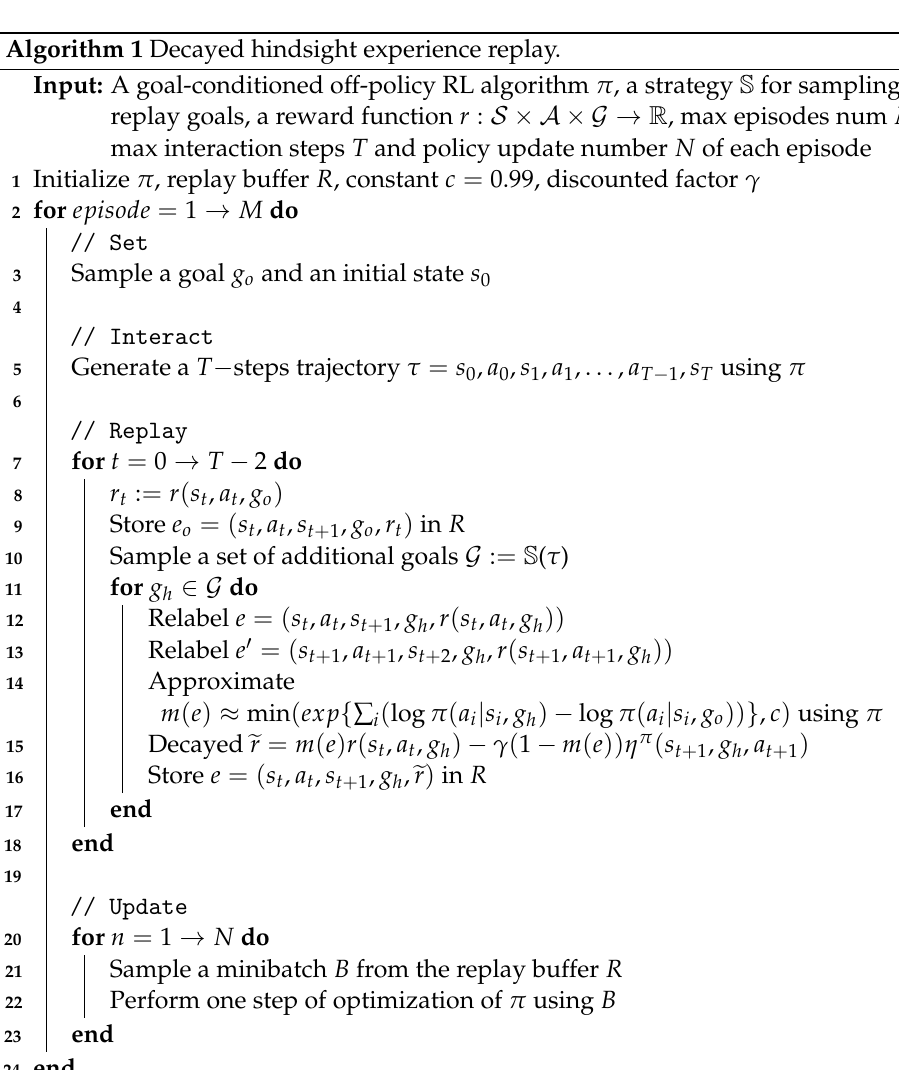
Algorithm 1 Decayed hindsight experience